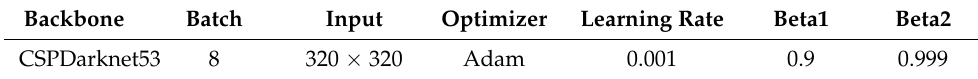
Table 3. Hyperparameters for model training.